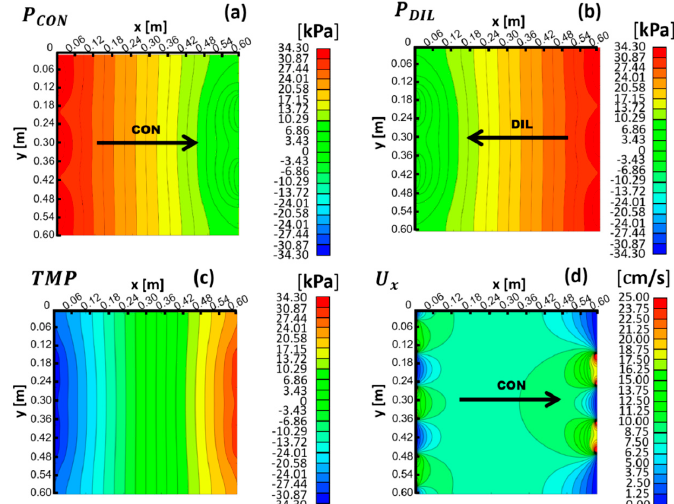
Figure 15. Results for a cross flow stack of 0.6-m sides at P in − P out = 34.3 kPa ( (cid:104) U s (cid:105) = 8.5 cm / s) in the absence of membrane deformation: maps of relative pressure in the CON ( a ) and DIL ( b ) channels, TMP ( c ), and superficial velocity along the x direction in the concentrate channel ( d ).